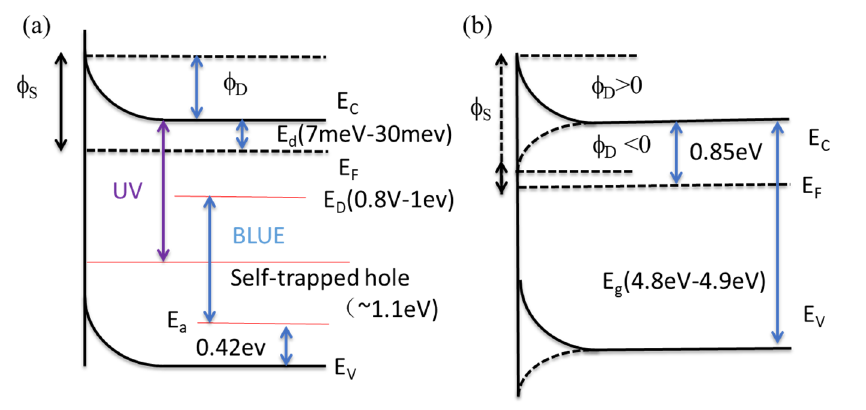
Table 1. Sample specifications.